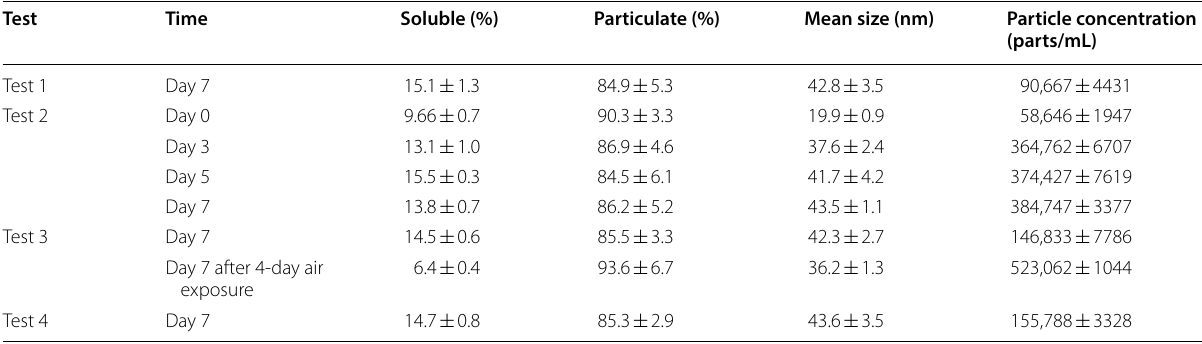
Table 4 Fractions of soluble and particulate U and size distribution of particulate U in EPS extracts detected by ICP-MS (diluted 200